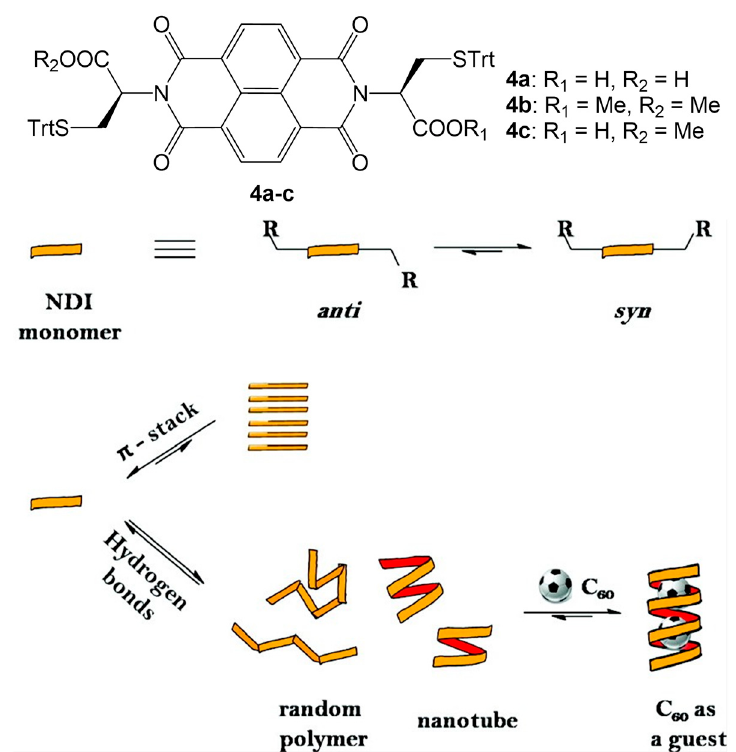
Figure 6. Amino acid functionalized NDIs 4a – c . Schematic representation of the equilibria between anti and syn conformations of the NDI monomer (on top) and possible NDI aggregates (above). Partially reproduced with permission from Ref. [46] (© American Chemical Society).